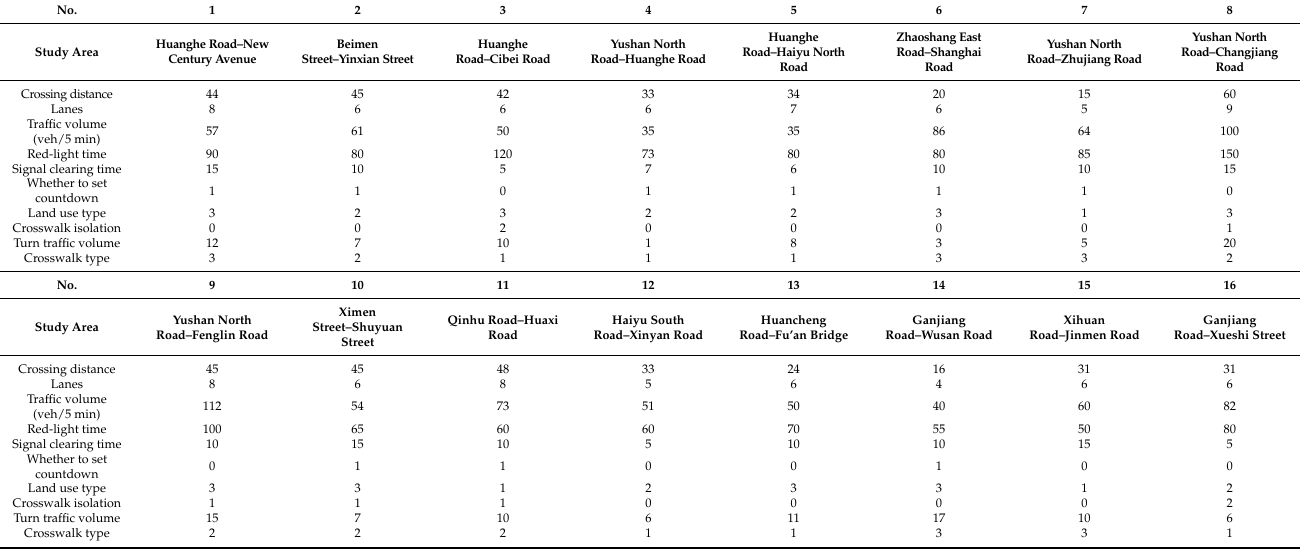
Table A2. Data statistics of signalized